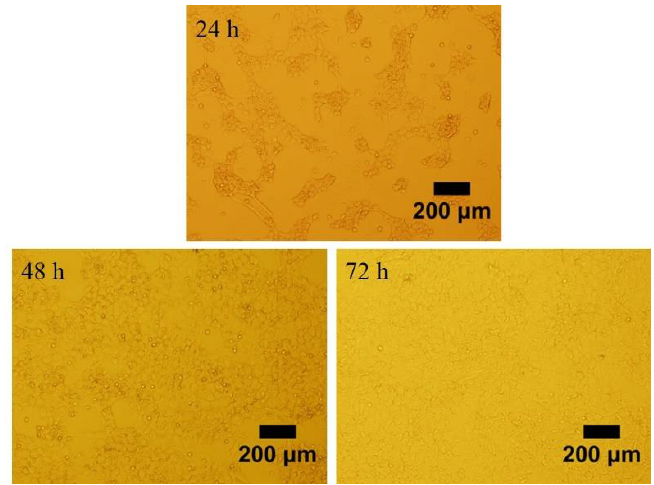
Figure 1. The preovulatory follicles of Hen’s granulosa cells cultured for 24, 48 and 72 h of post isolation. Scale bar, 200 μm.